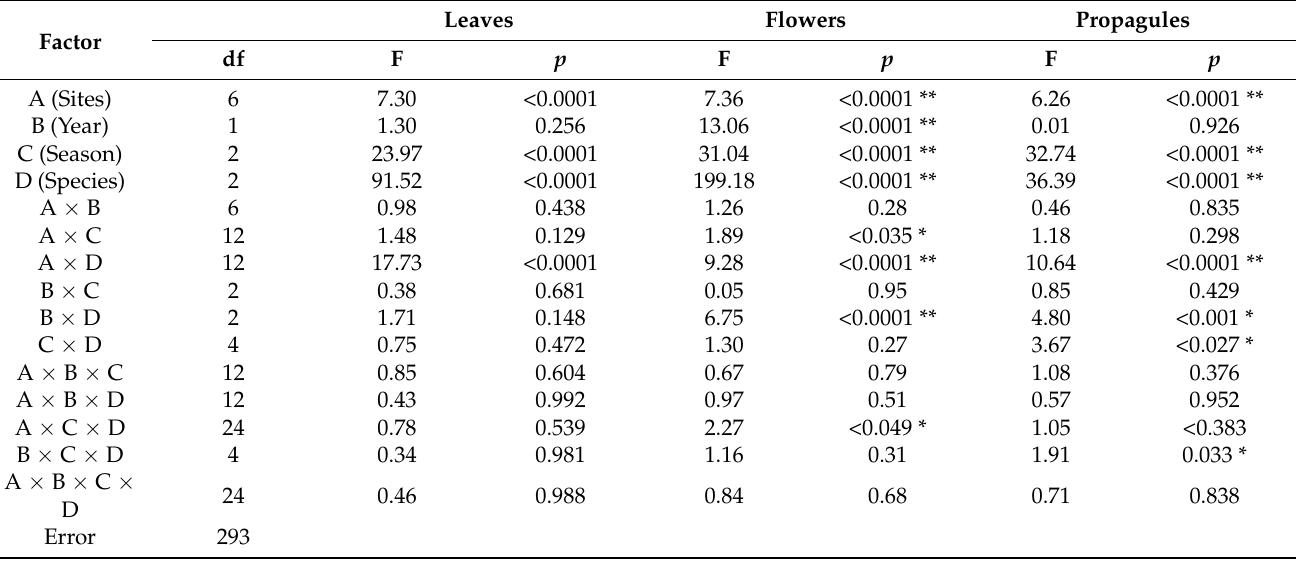
Table 5. Results of a four-factorial repeated-measurement ANOVA on the effects of site (Peten Neyac, R í o Verde, Champot ó n, Sabancuy, Xibuja, Estero Pargo and Atasta), year (2009 and 2010), season (dry, rainy and Nortes) and species ( Rhizophora mangle , Avicennia germinans and Laguncularia racemosa ) on the litter fall production and components along the Campeche coast, with a significance level of p < 0.05.